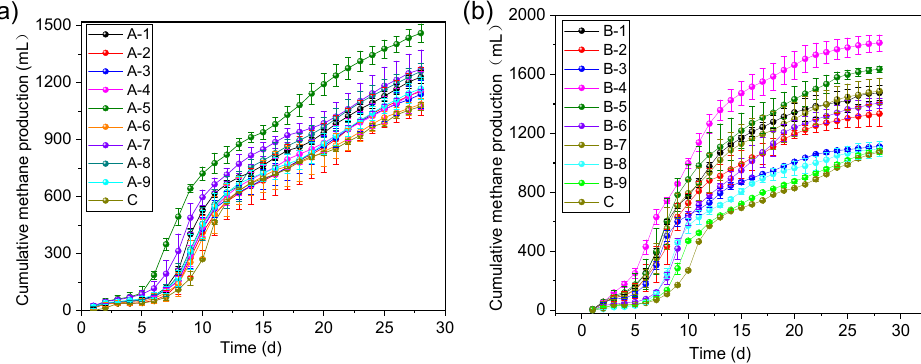
Figure 3. Cumulative methane production during anaerobic fermentation with ( a ) CABC and ( b ) PABC as a supplement. ( b ) PABC as a